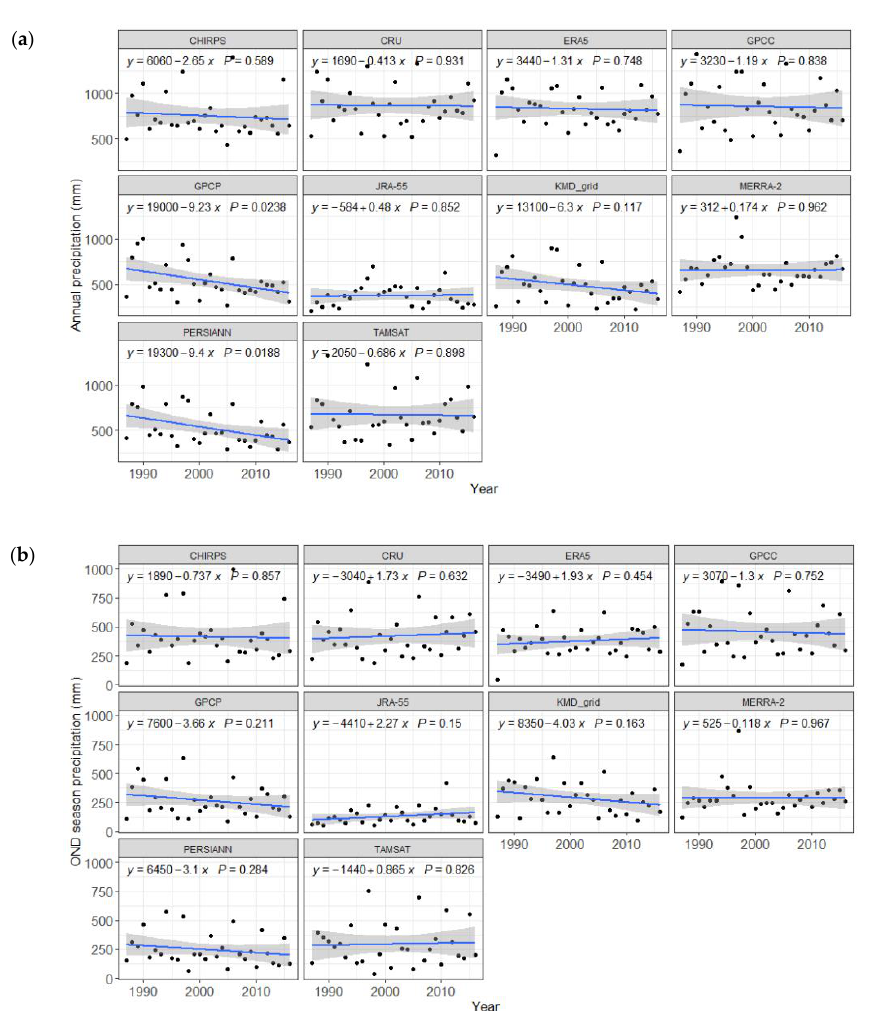
Figure 7. Non-significant seasonal precipitation trends for the 10 products: ( a ) March–April–May and ( b ) October-November-December. The black dots represent annual precipitation values with the blue line indicating the linear regression.